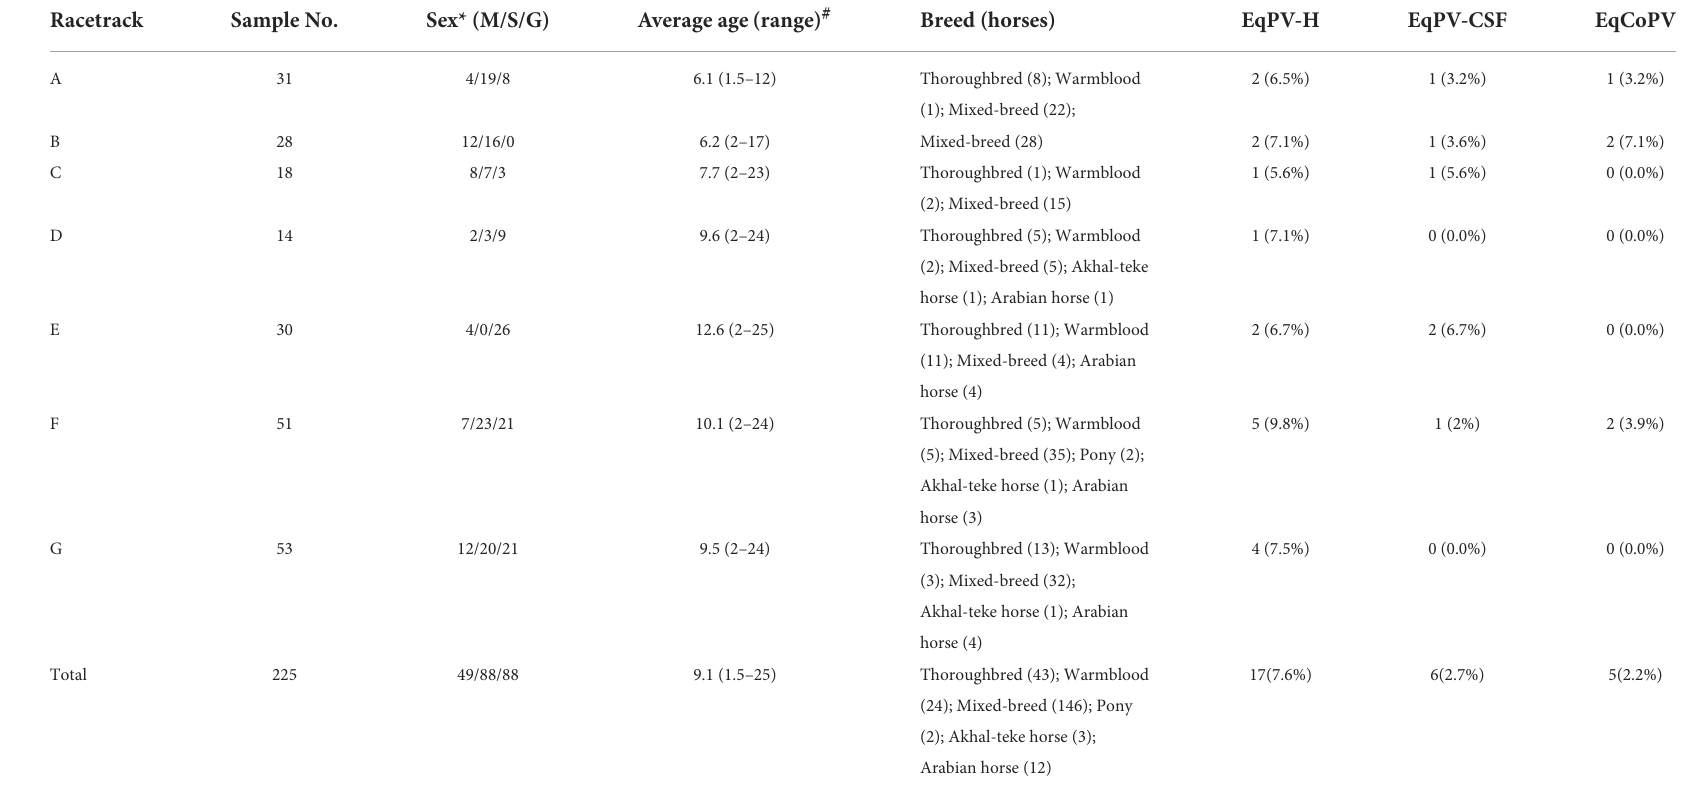
TABLE 2 Characteristics of horses that serum samples were collected from in our study. Racetrack Sample